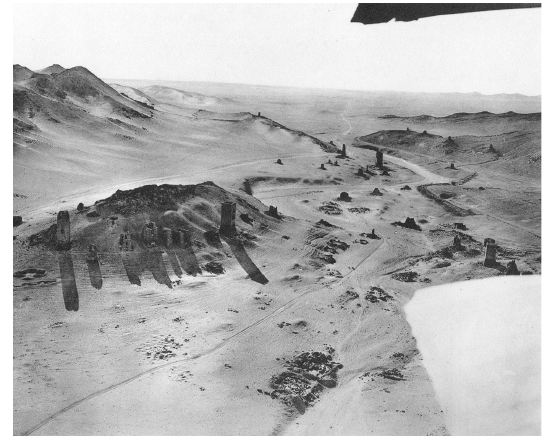
Figure 5. The circular plan of Hatra.